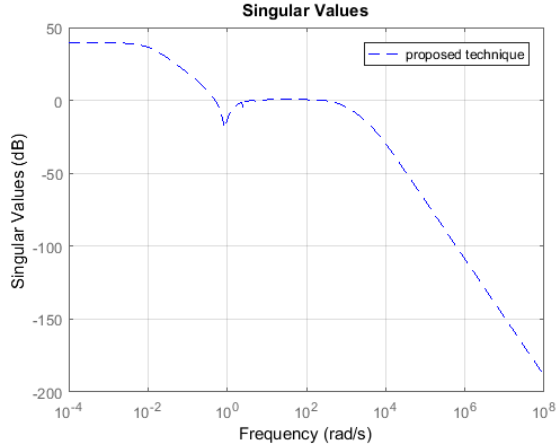
Figure 11. Sigma plot of K ( s ) P ( s ) .